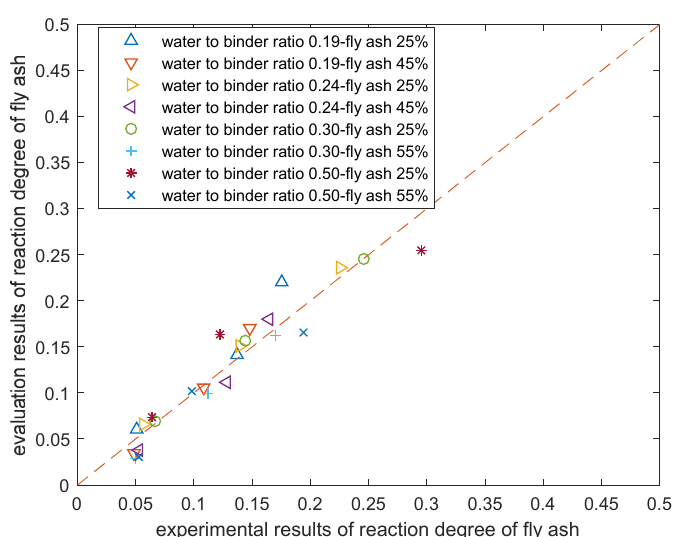
Figure 1. Experimental versus analytical data of reaction extent of fly ash.